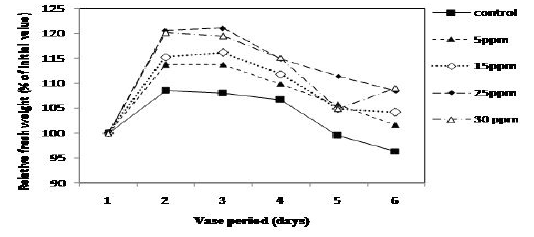
Fig. 2. Effect of different concentration of SNPs on relative fresh weight during first six days of L. orientalis ‘Bouquet’ vase life